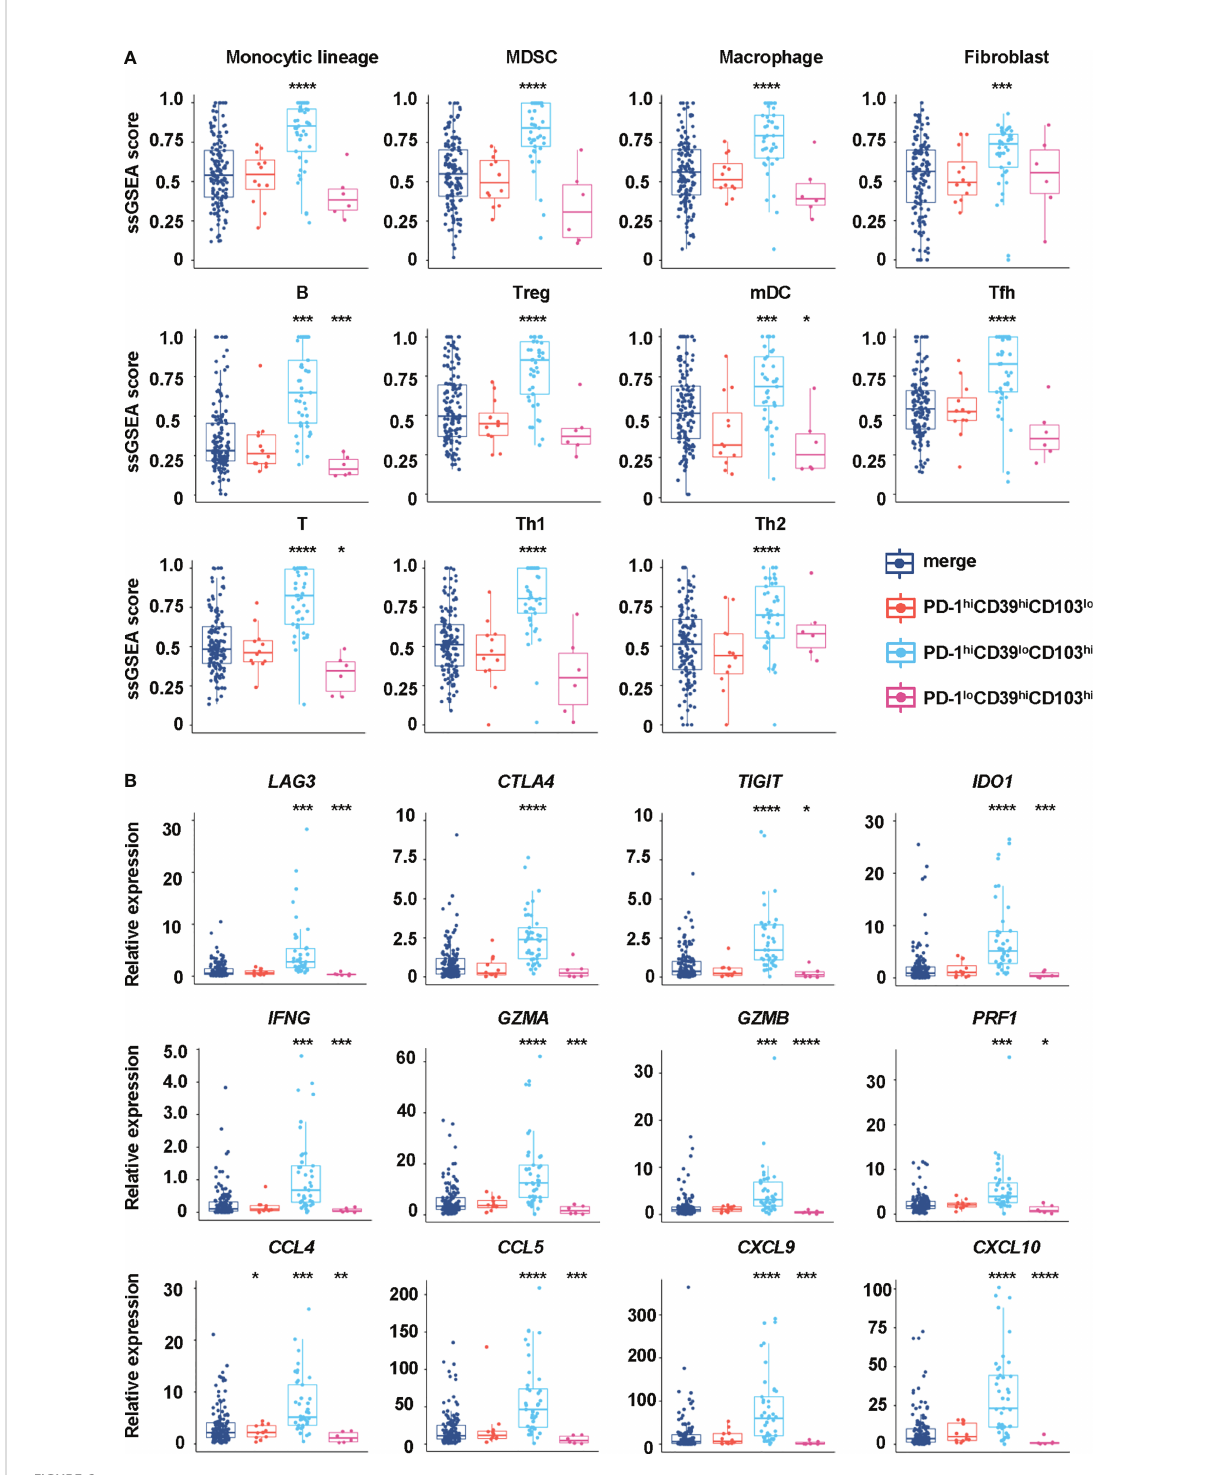
FIGURE 6 Differences in immune cells and regulatory factors in CD8 hi T-cell subsets. (A) GSVA enrichment scores of the classical gene signatures for immune cells among the PD-1 hi CD39 lo CD103 hi , PD-1 hi CD39 hi CD103 lo , and PD-1 lo CD39 hi CD103 hi clusters and the other fi ve clusters. (B) The mRNA expression of immune cell regulatory factors in the PD-1 hi CD39 lo CD103 hi , PD-1 hi CD39 hi CD103 lo , and PD-1 lo CD39 hi CD103 hi clusters compared with the other fi ve clusters. *p < 0.05; **p < 0.01; ***p < 0.001; ****p <